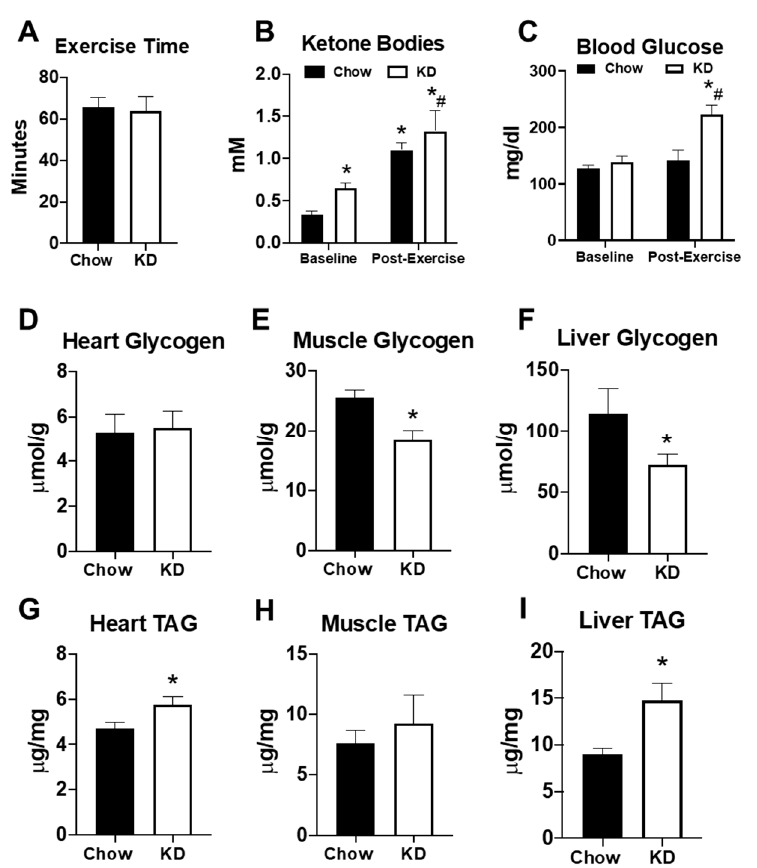
Figure 5. The effects of a ketogenic diet on exercise and endogenous metabolism. ( A ) Exercise time in the endurance exercise capacity test in chow-fed ( n = 6) and ketogenic diet (KD, n = 4) mice; ( B ) serum ketone bodies and ( C ) serum glucose levels in chow ( n = 6) and ketogenic diet ( n = 4) mice measured at the beginning (baseline) and at end of the exercise capacity test (post-exercise). Glycogen content measured in the ( D ) heart, ( E ) gastrocnemius, and ( F ) liver in chow-fed ( n = 6) and ketogenic diet ( n = 9) mice; triacylglycerol (TAG) content measured in the ( G ) heart, ( H ) gastrocnemius, and ( I ) liver in chow-fed ( n = 6) and ketogenic diet ( n = 9) mice. * p < 0.05 vs. chow or baseline. # p < 0.05 vs. chow-post-exercise.